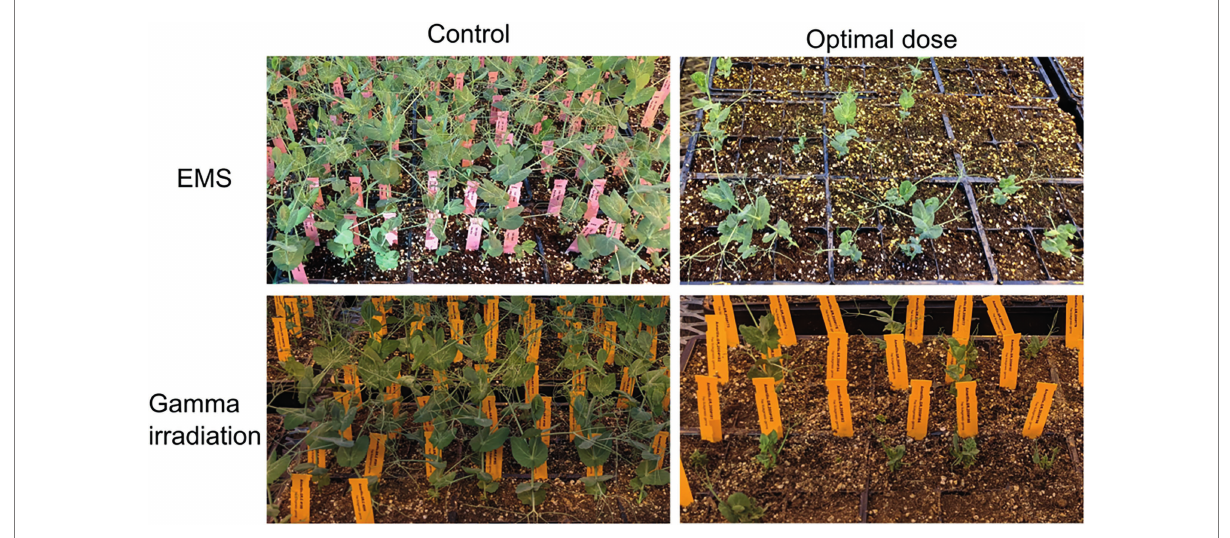
FIGURE 3 Comparative growth phenotypes of plants derived from pea seeds treated with optimized doses of mutagen and their respective controls. The upper panel shows growth phenotype of control (0 mm EMS, upper left panel) and optimal EMS dose (5 mm, upper right panel) treated M 0 pea plants. The lower panel shows growth phenotype of control (untreated, lower left panel) and optimal gamma irradiation dose (250 Gy, lower right panel) treated M 0 pea